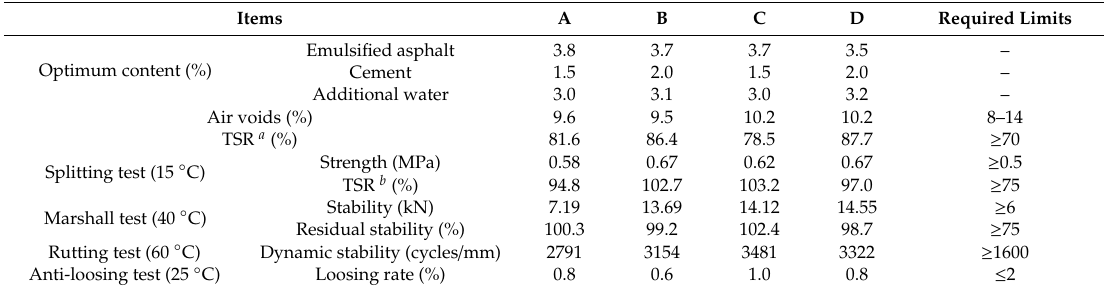
Figure 2. Gradation of cold recycling (CR) mixture. Table 2. Results of performance tests for cold recycling (CR) mixtures.